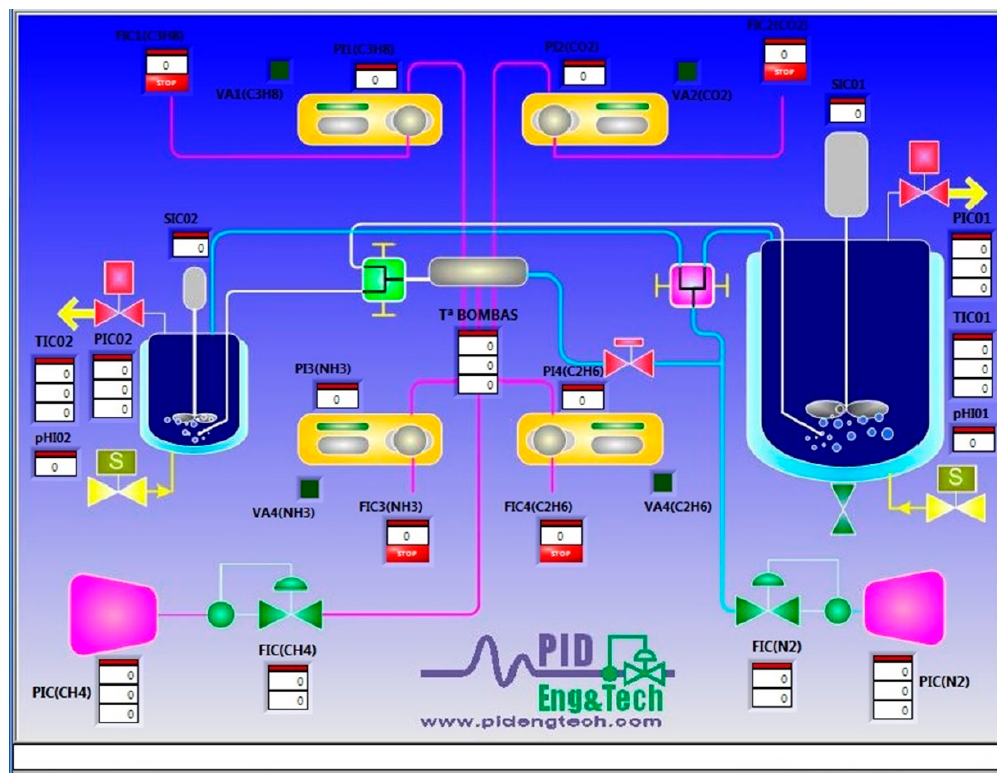
Figure 9. Pilot plant software interface (PID Eng & Tech).